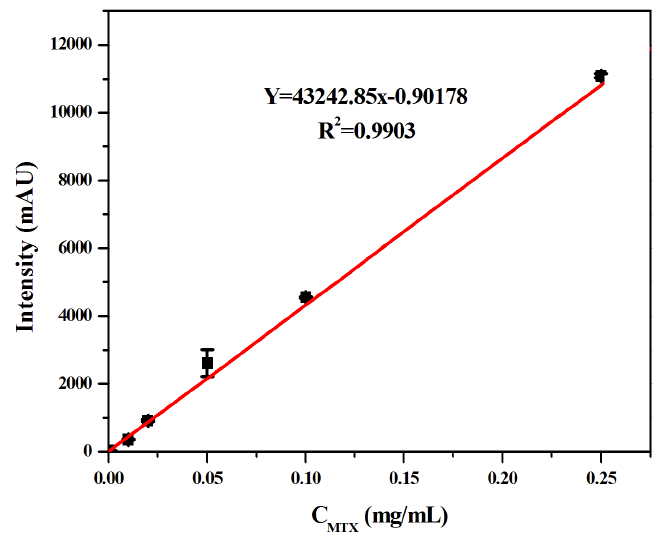
Figure 10. Linear curves between MTX liquid chromatography peak area and its concentration.